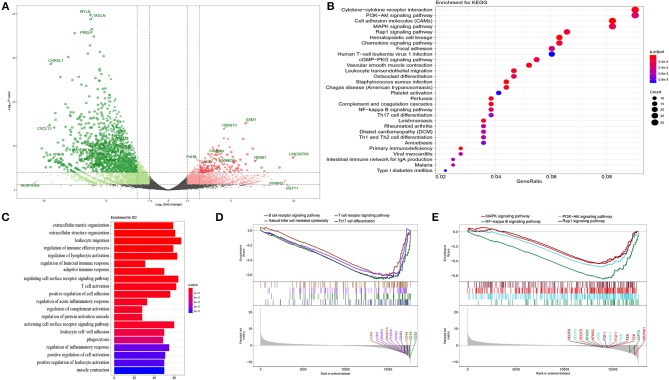
Functional annotation. (A) Volcano plot of DEGs in bladder cancer compared with adjacent tissue. P-value were counted by the Wald test. Candidate hub genes were shown with different colors. (B) Bubble plot of top 30 enrichment of KEGG pathways. P-values were shown by different color, the size of bubble indicate the gene count of each pathway. (C) GO enrichments were arranged by top 20 significantly p values. (D,E) GSEA of whole transcription from RNA-seq, p-value was made by Kolmogorov-Smirnov test.